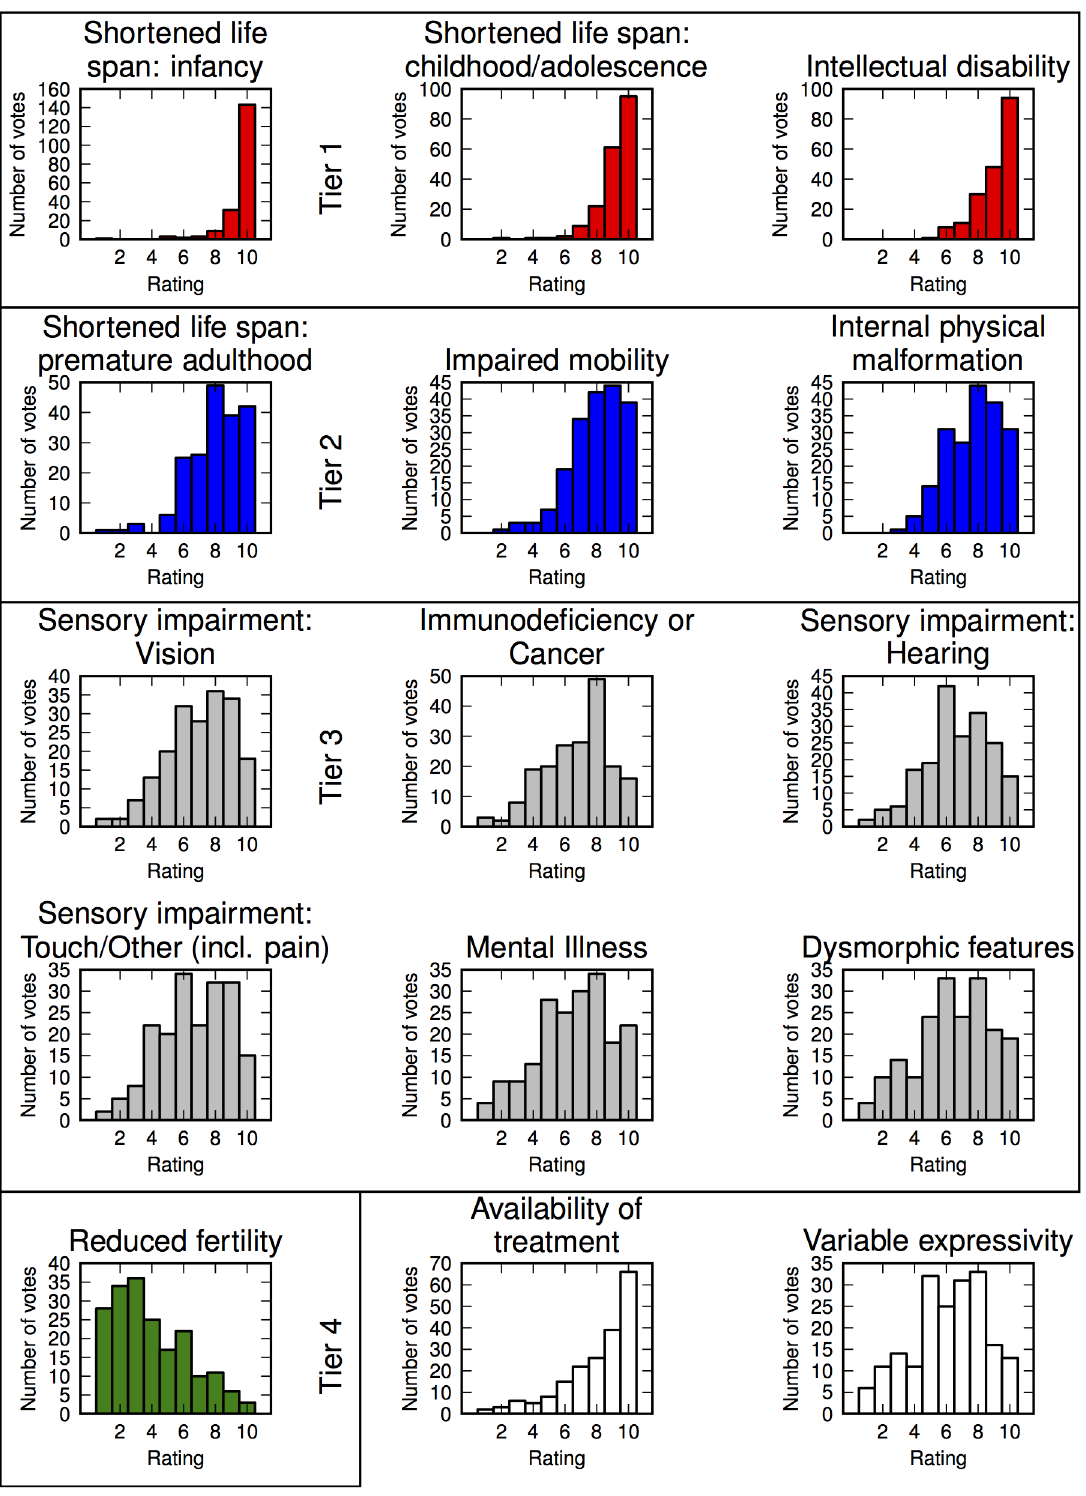
Fig. 2. Distribution of disease characteristic severity